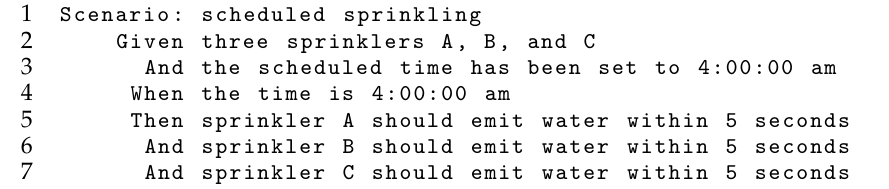
Figure 2. Scheduled sprinkling